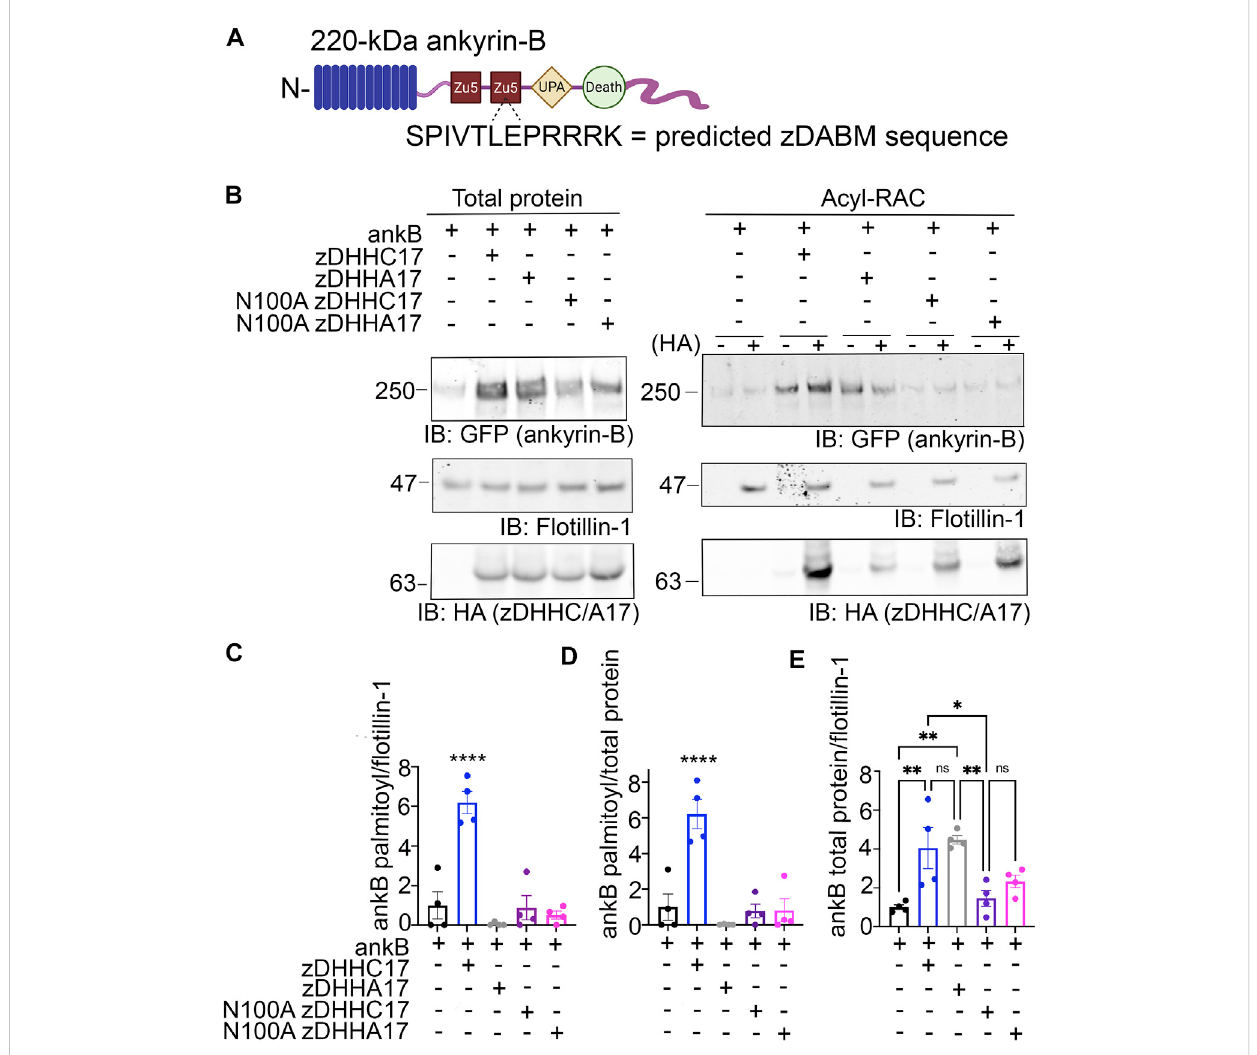
FIGURE 2 zDHHC17 recognizesthezDABMdomain ofankyrin-B toregulateankyrin-Bproteinexpression and palmitoylationinHEK293T cells. (A) .Schematic ofankyrin-BwiththepredictedzDHHCANKrepeatbindingmotifsequence(zDHHC17recognitionsite,predictedfrom(Lemonidisetal.,2017))locatedin the second ZU5 domain. (B) . Representative western blot showing total protein levels of ankyrin-B-GFP ( left ) and palmitoylation levels of ankyrin-B-GFP ( right ) from lysates of HEK293T cells transiently transfected with WT ankyrin-B-GFP alone or together with WT zDHHC17, enzymatically-dead zDHHA17,N100A zDHHC17, orN100A zDHHA17subjected to theAcyl-RACassay. Ankyrin-B-GFPproteinandpalmitoylation levels are detected withan antibody against GFP. Palmitoylation of ankyrin-B-GFP is strongly detected in a hydroxylamine-dependent manner ( ’ +HA ’ lane), compared to the backgroundsignalinthenegativecontrol ‘ -HA ’ lane.Co-expressionofzDHHC17increasesboththeproteinlevels( left )andpalmitoylationlevels( right )of ankyrin-B-GFP, compared to ankyrin-B expressed alone. WT ankyrin-B-GFP with zDHHA17, N100A zDHH17, or N100A zDHHA17 is not palmitoylated, compared to when ankyrin-B-GFP is co-expressed with zDHHC17. Ankyrin-B-GFP protein levels are unaffected by co-expression of zDHHA17, but are drastically reduced with co-expression of N100A zDHHC17 or N100A zDHHA17. (C) . Quanti fi ed S -palmitoylation levels of ankyrin-B-GFP from N = 4 independent replicates per condition from (A) . **** p < 0.0001 relative to ankyrin-B alone; one-way ANOVA with Tukey ’ s post-hoc test. For each condition, the palmitoylation signal was calculated by subtracting the − HA lane signal from that of the +HA lane and normalized to the fl otillin-1 signal from the +HA lane, and normalized again to the average of ankyrin-B alone signal to get the relative fold change in ankyrin-B-GFP palmitoylation. (D) . Quanti fi ed ankyrin-B-GFP S -palmitoylation levels normalized to total ankyrin-B protein levels for each condition, relative to ankyrin-B alone palmitoylation levels. Data from N = 4 independent replicates per condition from (A) . **** p < 0.0001 relative to ankyrin-B alone; one-way ANOVA with Tukey ’ s post-hoc test. (E) . Quanti fi ed ankyrin-B-GFP protein levels normalized to total fl otillin-1 levels, relative to ankyrin-B alone protein levels. Data from N = 4 independent replicates per condition from (A) . ** p < 0.01, * p < 0.05; one-way ANOVA with Tukey ’ s post-hoc